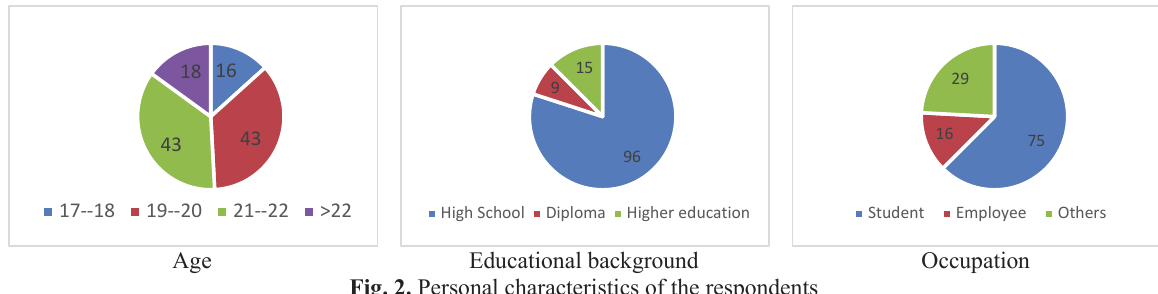
Fig. 2. Personal characteristics of the